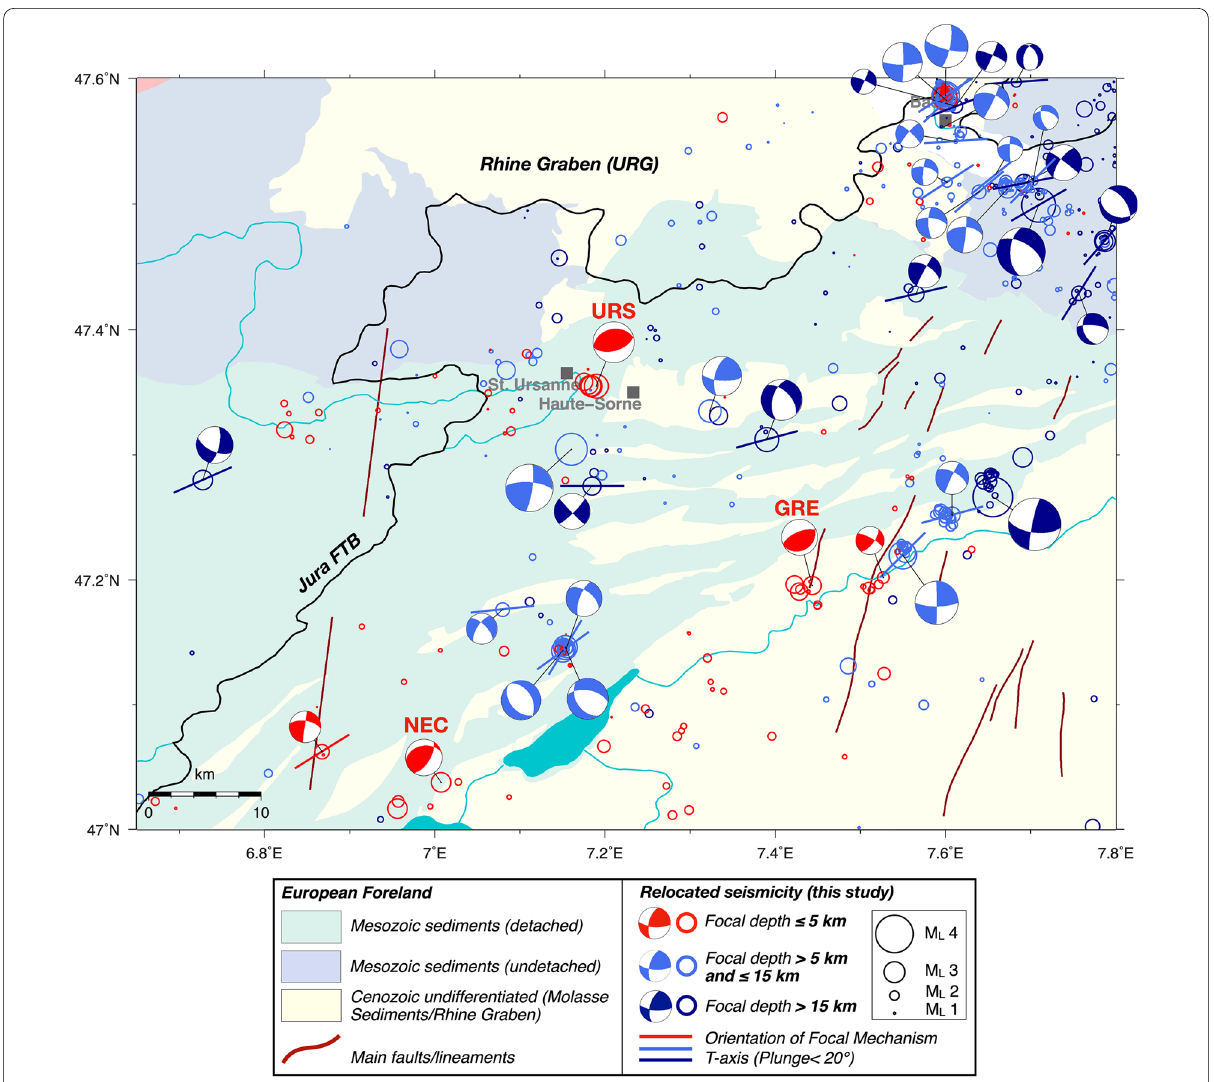
Fig. 12 Epicenters and focal mechanisms of earthquakes recorded by the Swiss Seismological Service in the northern tip of the Jura FTB between 1984 and 2021 (May 26 th ). Locations are absolute relocations obtained using the new 3D Pg focal mechanisms discussed in the text (bold labels) are Saint-Ursanne (URS), Grenchen (GRE), Neuchâtel (NEC). T axes with plunge plotted color-coded by the depths of the associated earthquakes. Background colors outline major tectonic units. Red lines indicate faults adopted from Heuberger et al. (2016), Mock and Herwegh (2017), Vouillamoz et al. (2017) and Swisstopo